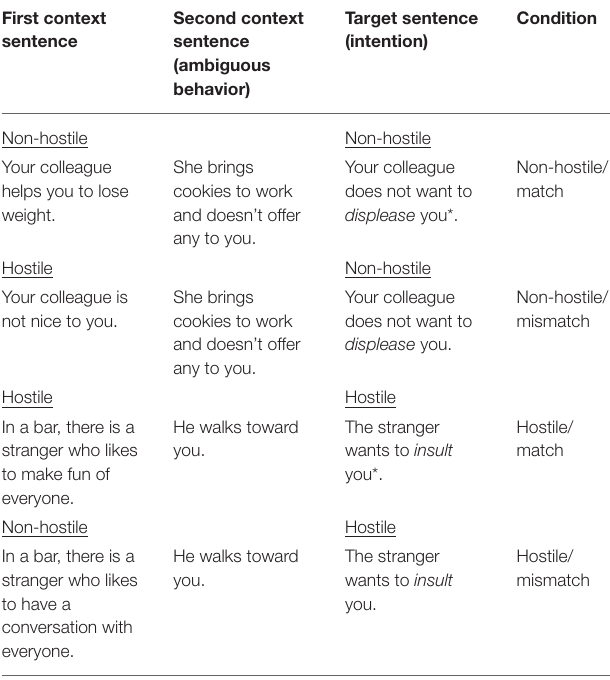
TABLE 2 | Examples of four possible scenario sentences (translated from original French